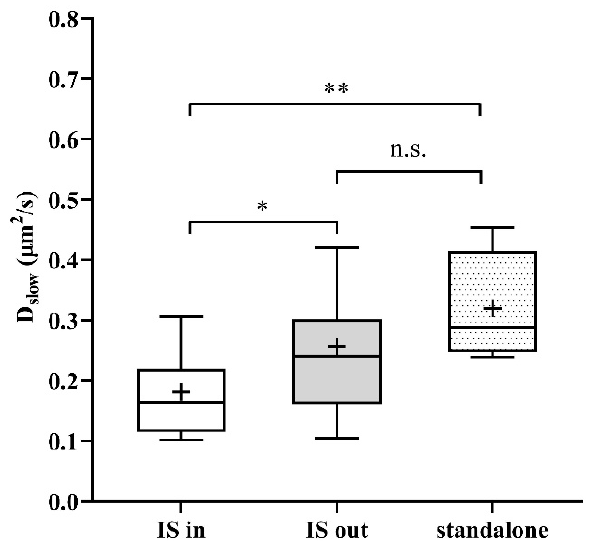
Figure 5. Mobility of IL-2 receptor α subunits labeled with Alexa 546-anti-Tac Fab on IS-forming Jurkat cells expressing WT mGFP-Kv1.3. IL-2R α diffuses significantly more slowly in the IS than outside it, which may be the consequence of a more crowded environment. * p < 0.05, ** p < 0.01.